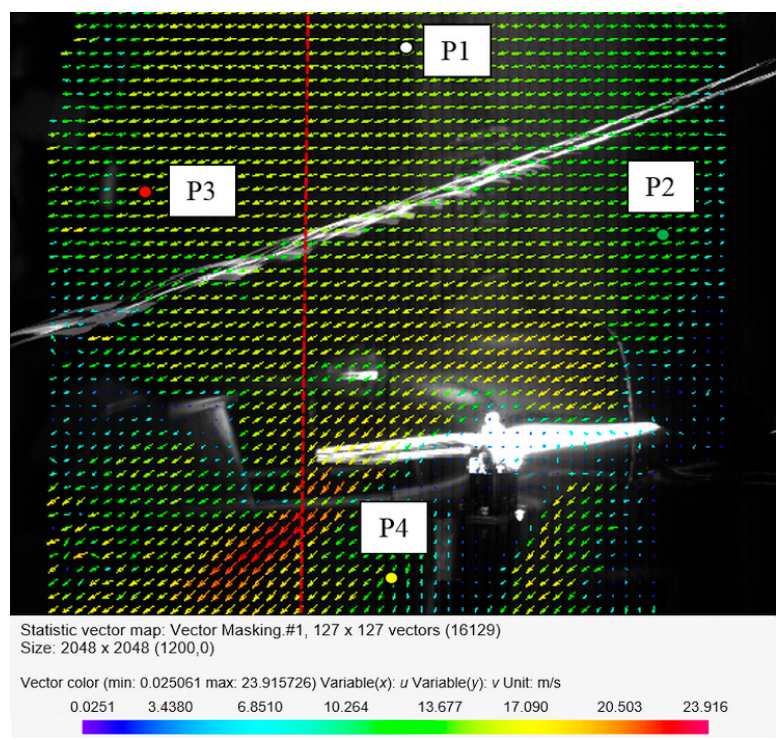
Figure 7. Location of the control points in the measurement space.